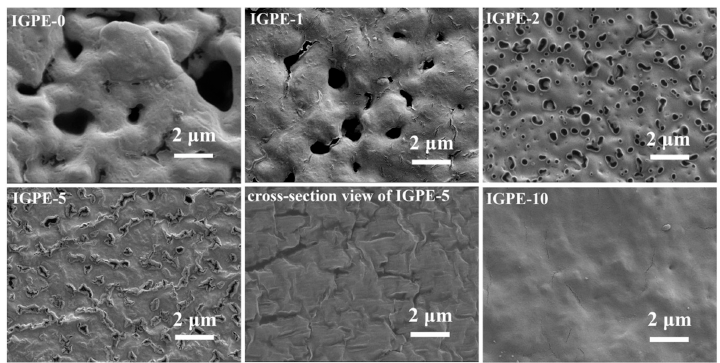
Figure 5. SEM images of different IGPE-X membranes, where the X refers to the length of time (in minutes) the gel spent in the coagulation bath. Reprinted with permission from Yang et al. [172].